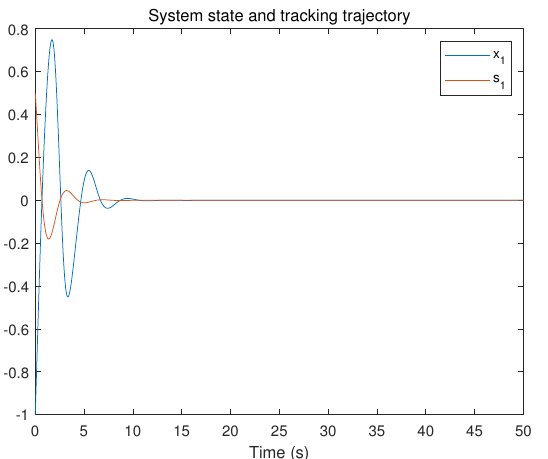
Figure 7. System state x 1 and its tracking trajectory when η 1 = − 0.5 and η 2 = 0.5.